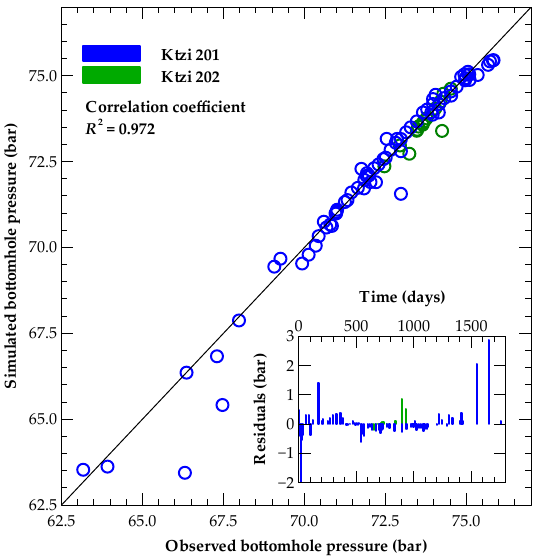
Figure 5. Observed versus simulated bottomhole pressures in the CO 2 injection phase exhibit a correlation coefficient of R 2 = 0.972. Residuals versus time are plotted in the inset.